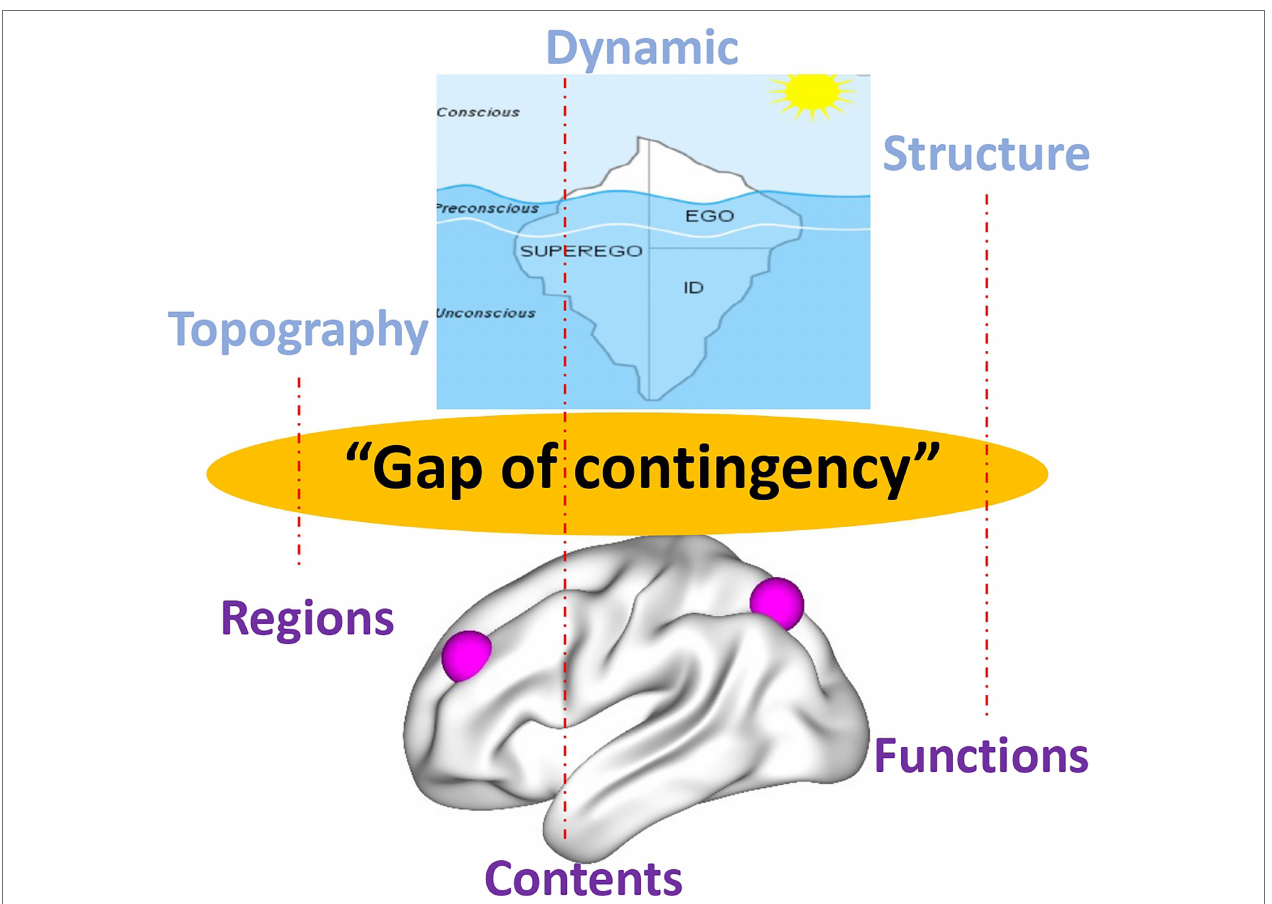
FIGURE 1 | Different models of the psyche in psychoanalysis (upper) and the brain in current neuroscience (lower) with red dotted lines indicating insufficient contingent connection, that is, “gap of